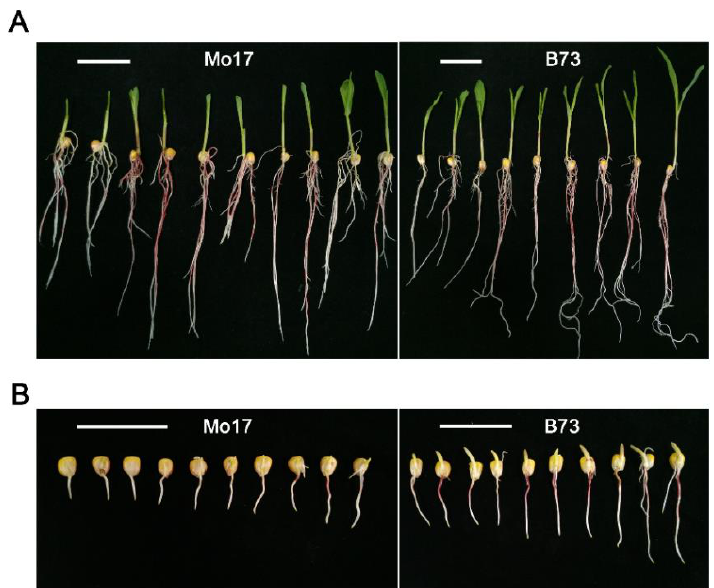
Figure 1. Morphological observation of Mo17 or B73 germinated seeds under optimum temperature or low temperature. ( A ) Photographs of Mo17 or B73 seeds/seedlings after imbibition for 7 days under optimum temperature (25 ◦ C); ( B ) photographs of Mo17 or B73 germinated seeds after imbibition for 21 days under low temperature (10 ◦ C). White scale bar represents 5 cm.